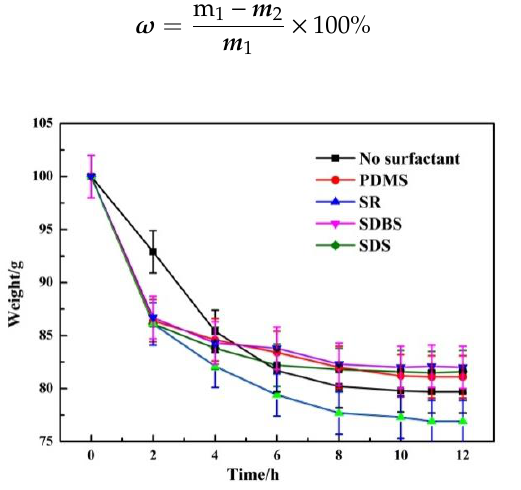
Figure 6. Of phosphogypsum changes with Figure 6. of phosphogypsum changes with time.